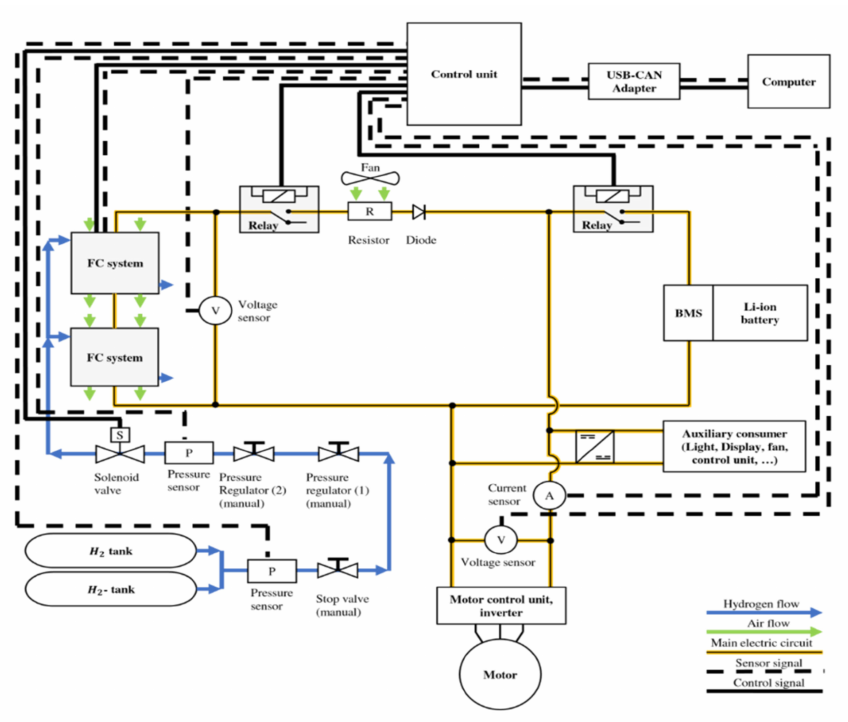
Figure 2. Architecture of the passive fuel cell/battery hybrid powertrain system for electric